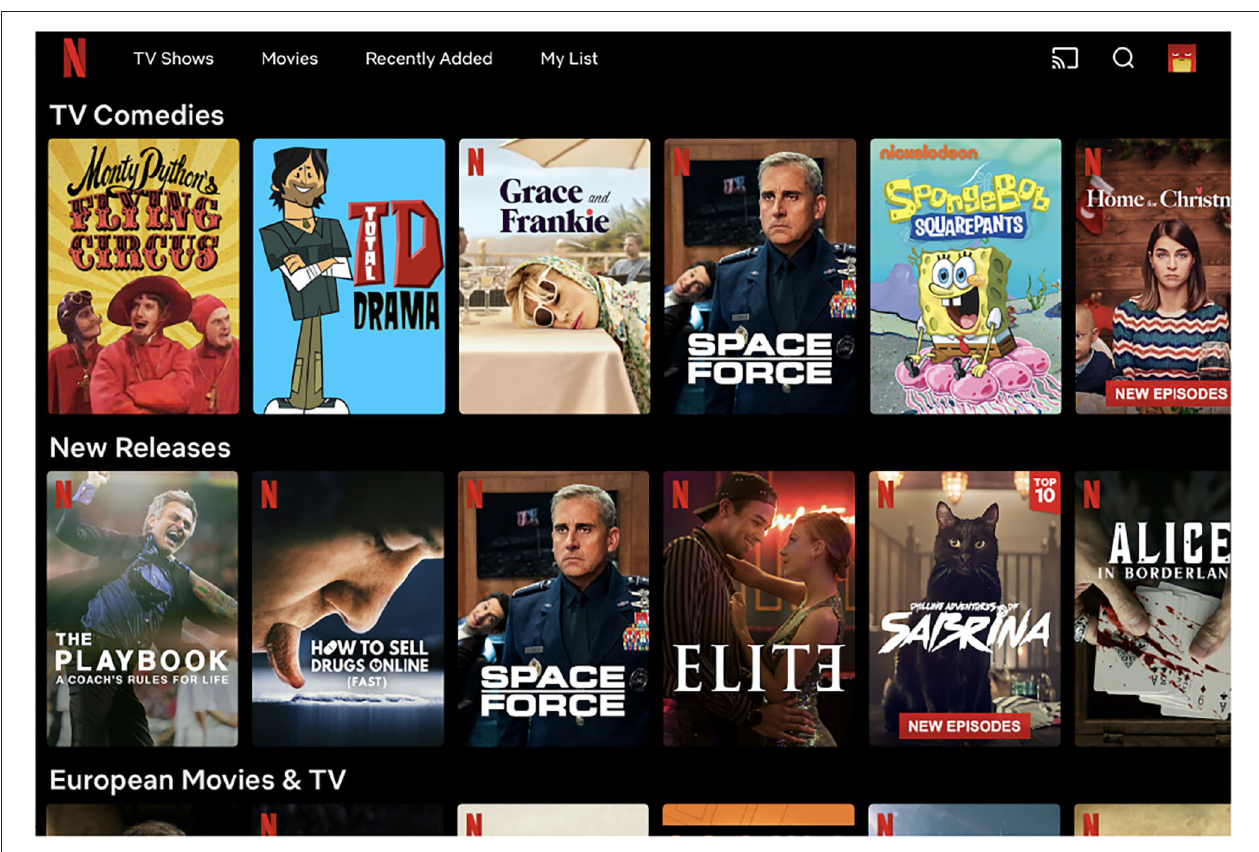
FIGURE 1 | The Netflix homepage, an example of the carousel user interface in the multimedia streaming